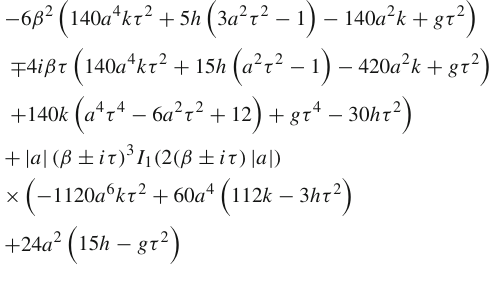
Fig. 30 Time variation of SFF for different N at β = 0. Here we shift reference axis[SFF] to SFF | τ = 0 (cid:8) (cid:8) (cid:9) − 6 β 2 − 140 a 2 k + g τ 2 140 a 4 k τ 2 + 5 h 3 a 2 τ 2 − 1